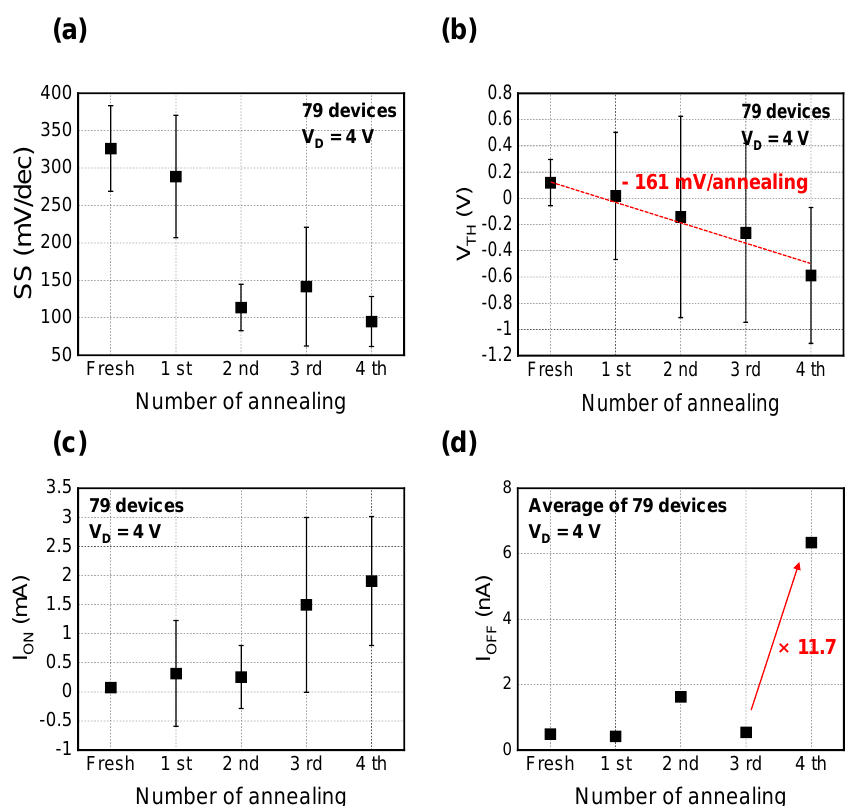
Figure 4. Extracted device parameters such as ( a ) SS, ( b ) V TH , ( c ) I ON , and ( d ) I OFF after iterative HPD. The symbol and error bar indicate the average value and standard variation, respectively. I ON and I OFF were extracted at V G = V TH + 2 V and V G = V TH − 2 V, respectively.